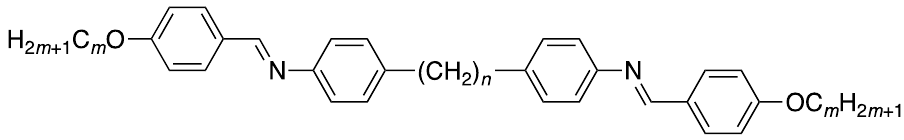
Figure 4. A sketch of ( a ) the monolayer smectic A phase ( d ~ l ) exhibited by symmetric liquid crystal dimers, and ( b ) the intercalated smectic A phase ( d ~ l/2 ) observed only rarely for symmetric liquid crystal